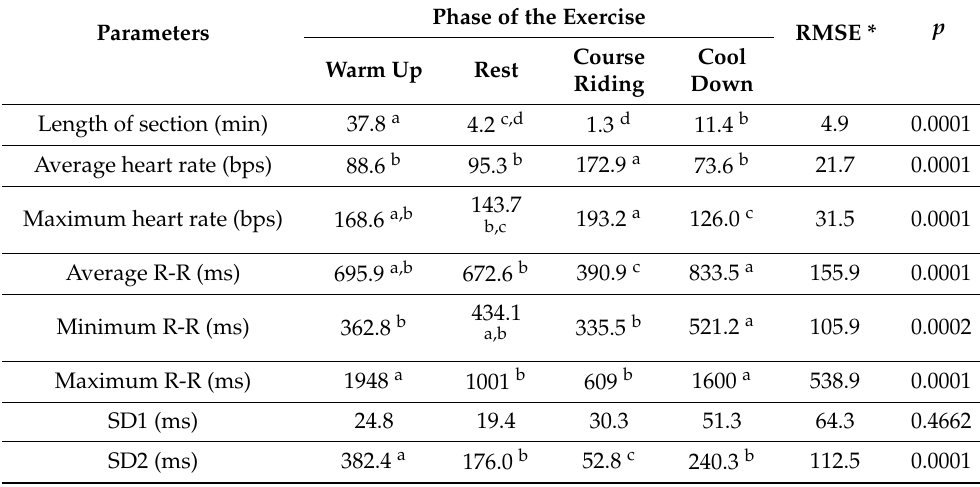
Table 2. The effect of phases of the exercise on the heart rate and heart rate variability parameters of show jumper